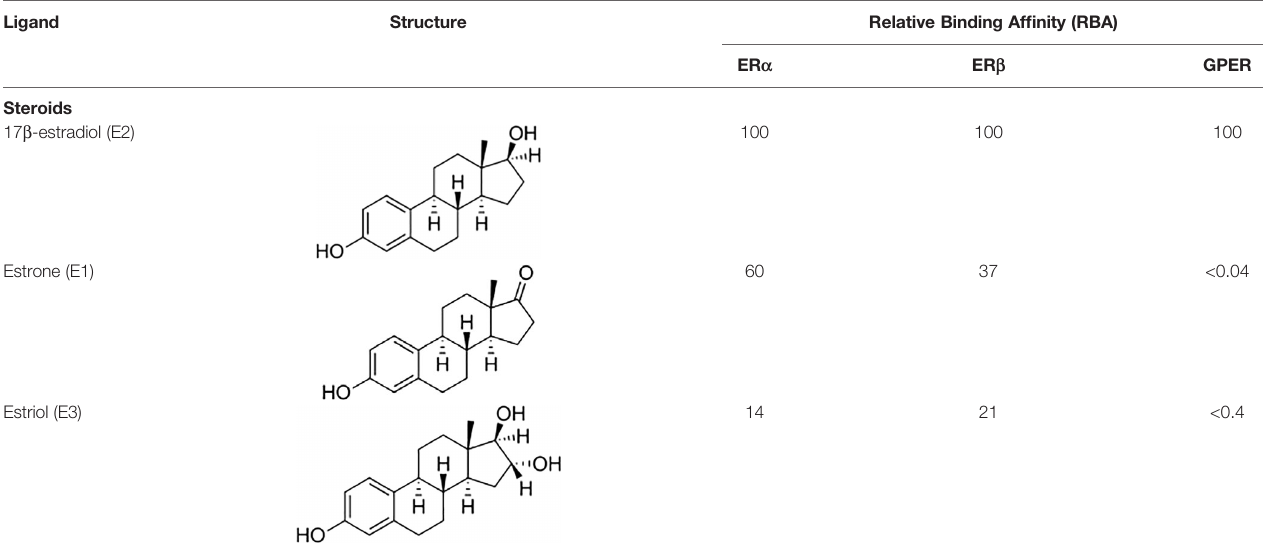
TABLE 1 | Relative binding af fi nities of estrogenic ligands to estrogen receptors.